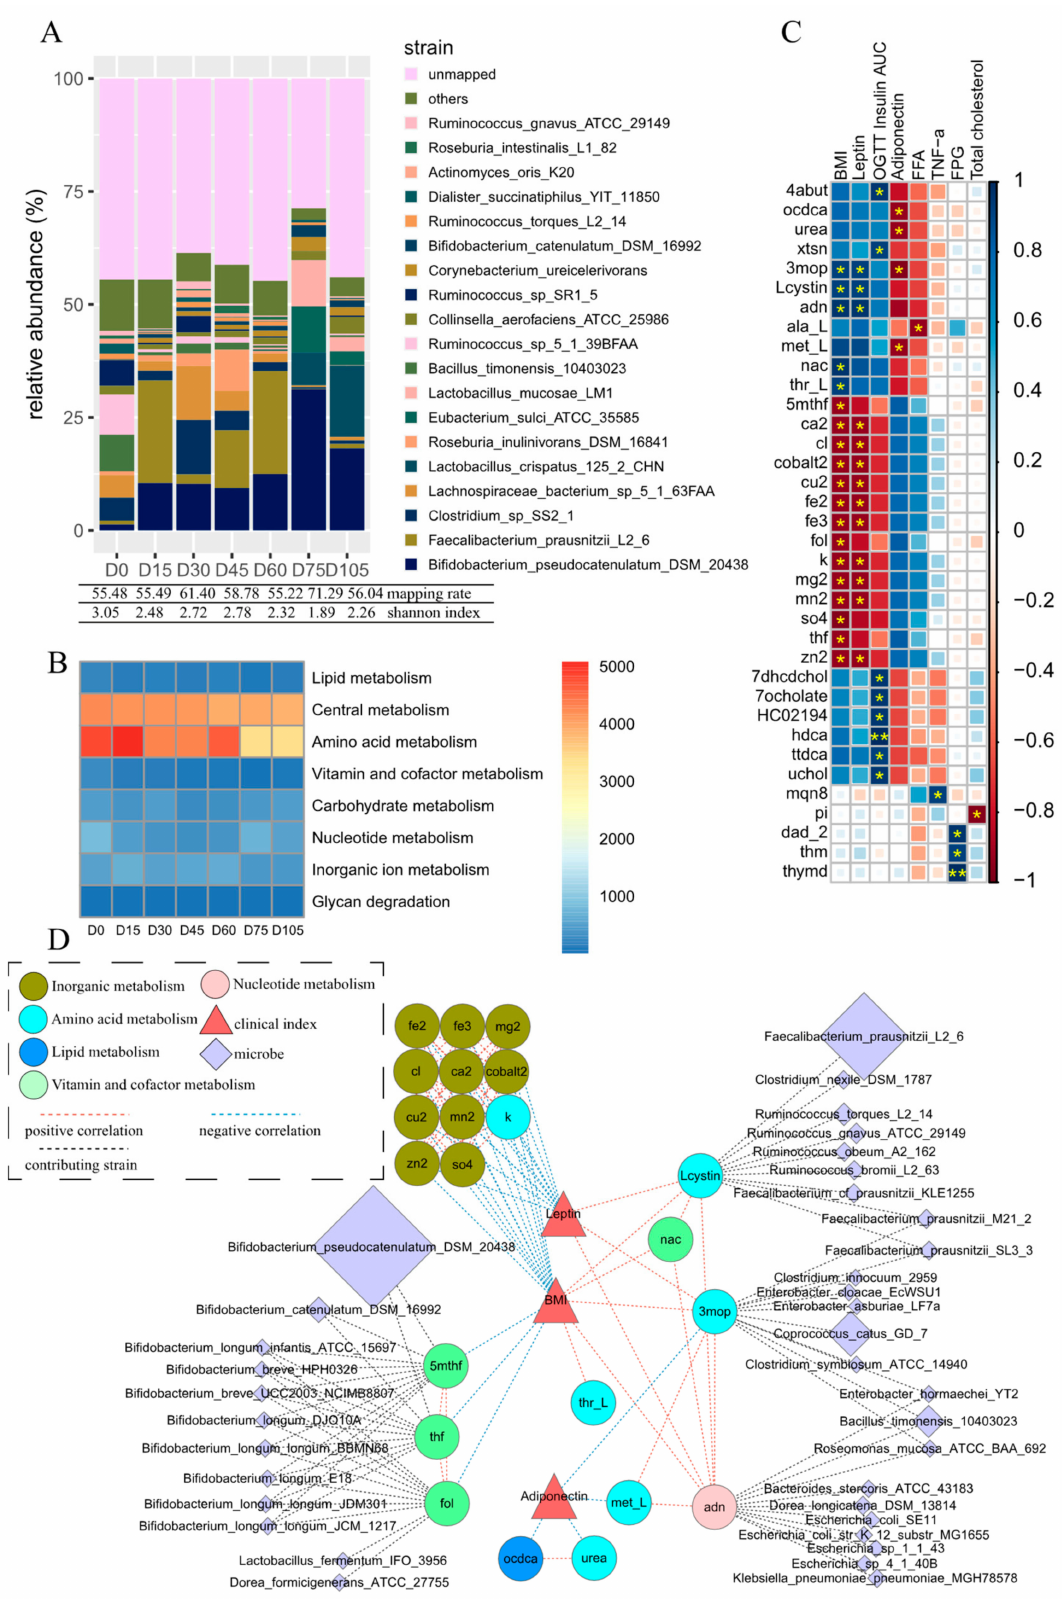
Figure 1. Results of metagenome-scale metabolic network simulation. ( A ) The relative abundance of gut strains at different dietary intervention timepoints. Data were obtained by mapping high-quality reads to the AGORA reference genomes. For the mapped strains, only the most abundant 19 strains are shown and the remaining strains are summed and